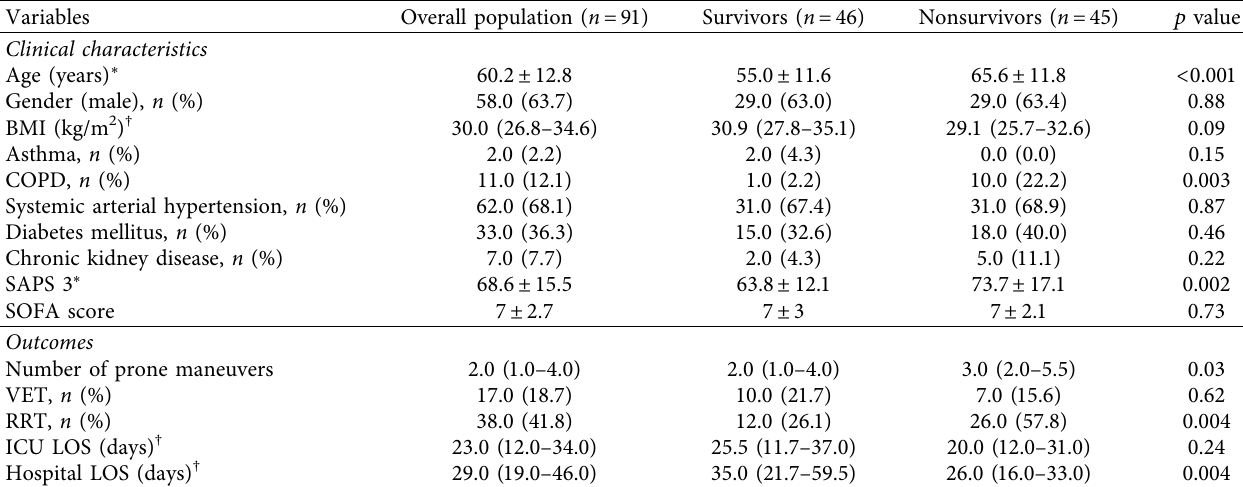
Table 1: Baseline characteristics and outcomes of included patients.